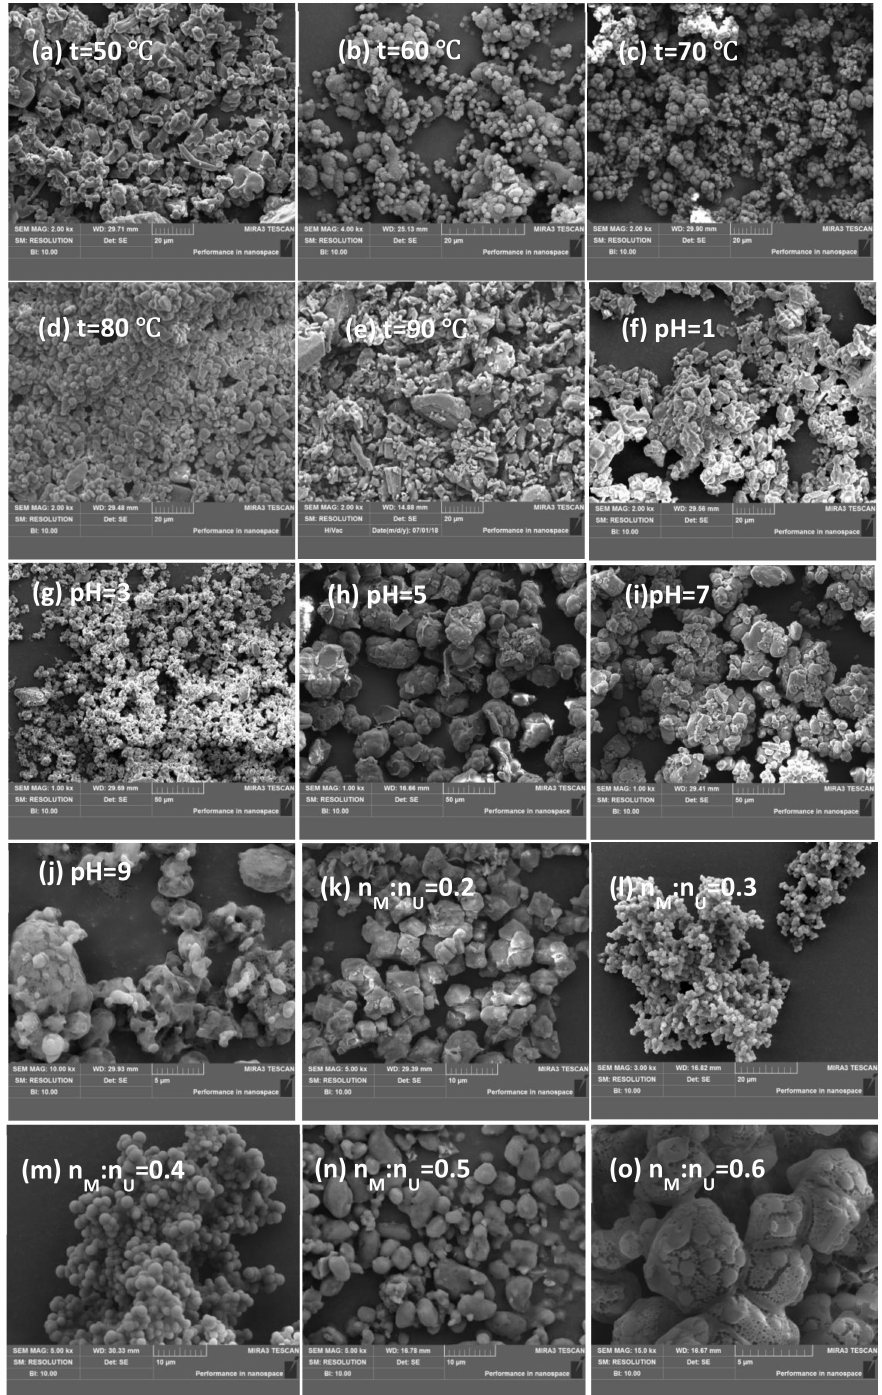
Figure 3. Scanning electron micrograph (SEM) of RDX / MUF composite energetic microspheres prepared under di ff erent